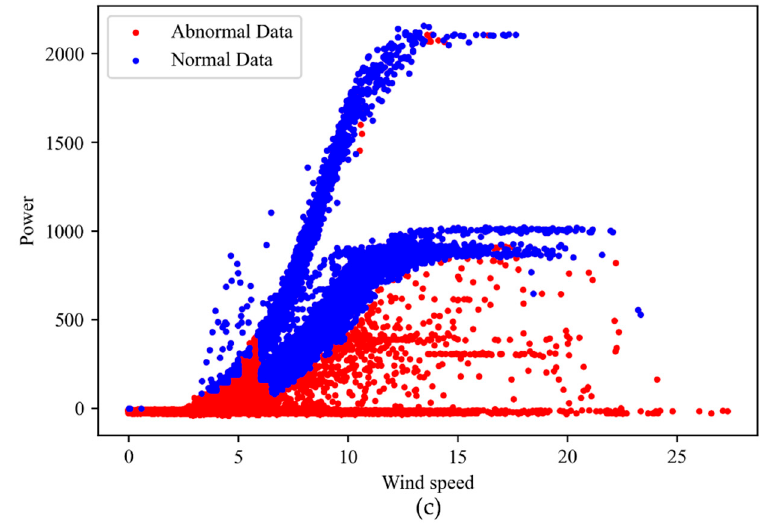
Figure 11. Abnormal data cleaning results using the OIV algorithm: ( a ) #1 wind turbine; ( b ) #2 wind turbine; ( c ) #3 wind turbine.